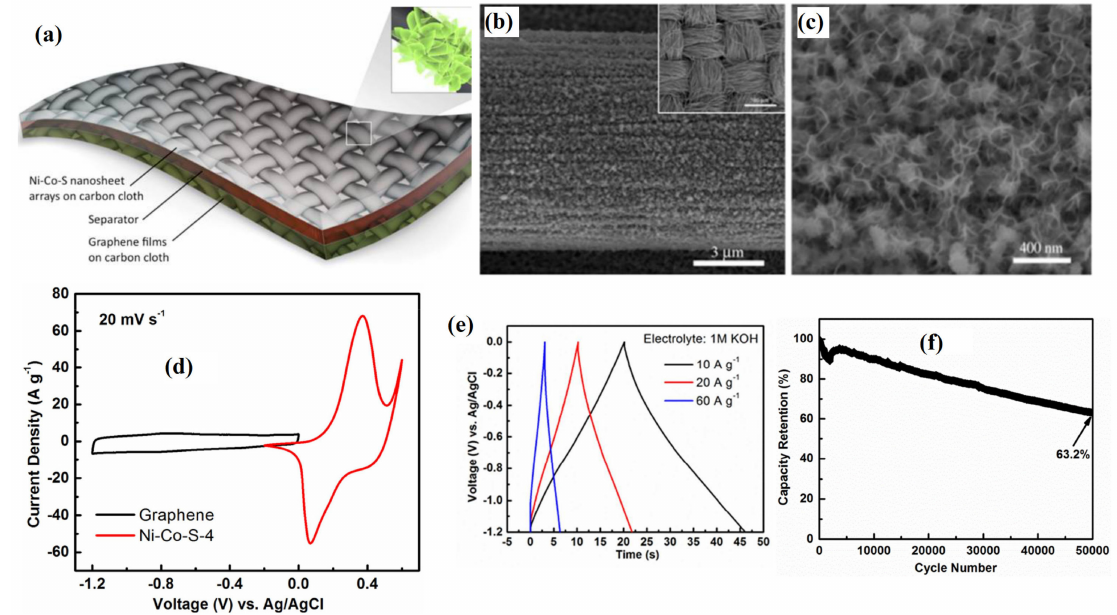
Figure 18. ( a ) Schematic fabrication of the asymmetric SCs. ( b , c ) SEM images of the Ni–Co–S-4 nanosheet arrays. ( d ) The CV profiles of the Ni–Co–S-4 (positive electrode) and graphene (negative electrode) in 1M KOH electrolyte. ( e ) GCD of the negative electrode in 1 M KOH electrolyte. ( f ) Cy- cling stability of the asymmetric SC. Adapted with permission [360]. Copyright (2014) American Chemical